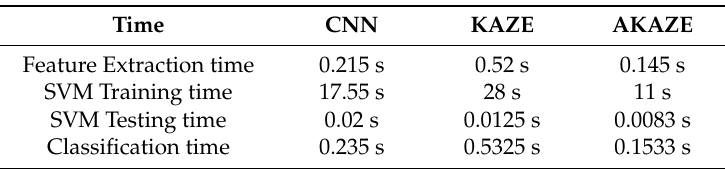
Table 4. Average time to process each image.